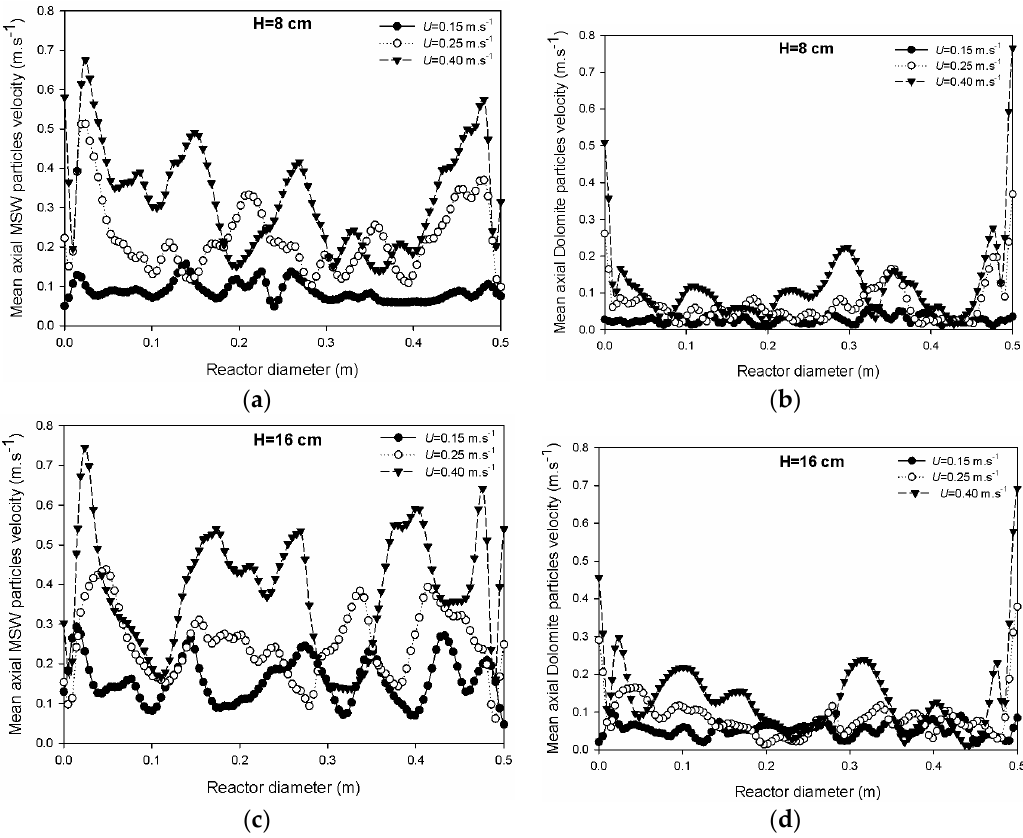
Figure 8. Solid particles time-mean axial velocity profiles at three different superficial gas velocities (0.15, 0.25, 0.4 m/s): ( a ) MSW velocity at 8 cm height; ( b ) dolomite velocity at 8 cm height; ( c ) MSW velocity at 16 cm height; ( d ) dolomite velocity at 16 cm height. MSW particle size 5 mm, dolomite particle size 0.5 mm, operating temperature 873 K and simulation time 3 s.